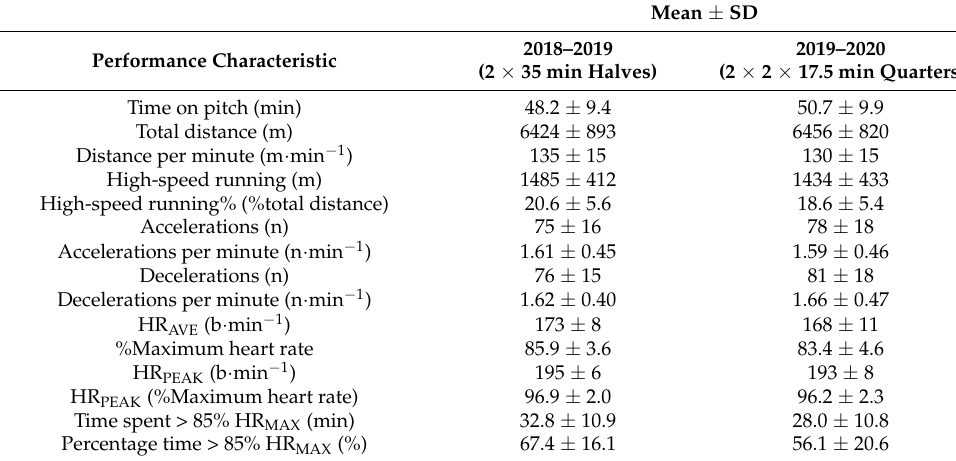
Table 1. Performance characteristics (descriptive data) of male university field hockey players during 70 min national-level matches, when the match format was 2 × 35 min halves (2018–2019 season) or 2 × 2 × 17.5 min quarters (2019–2020 season). Global Positioning System (GPS) and heart rate variables are presented as mean ± SD.